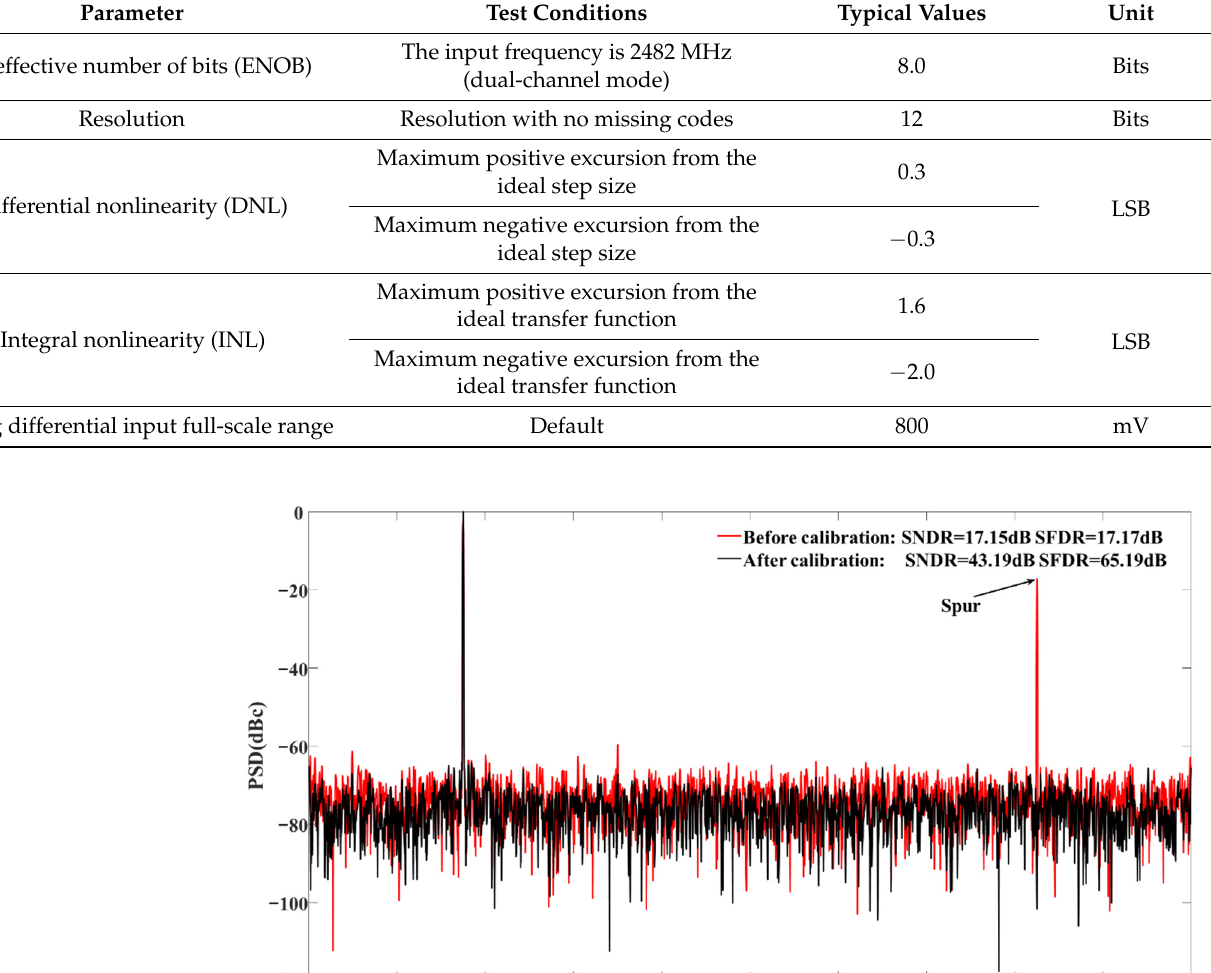
Figure 15. Experiment setup which is aimed to validate the proposed method. Table 5. The features of experimental equipment.